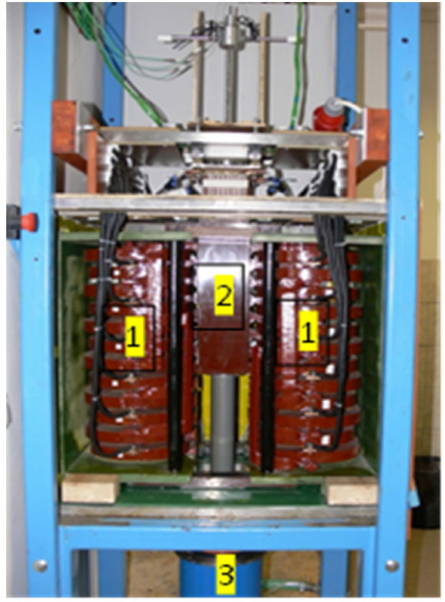
Figure 13. 2-pole TMF inductor (1) with the furnace (2) and the water tank